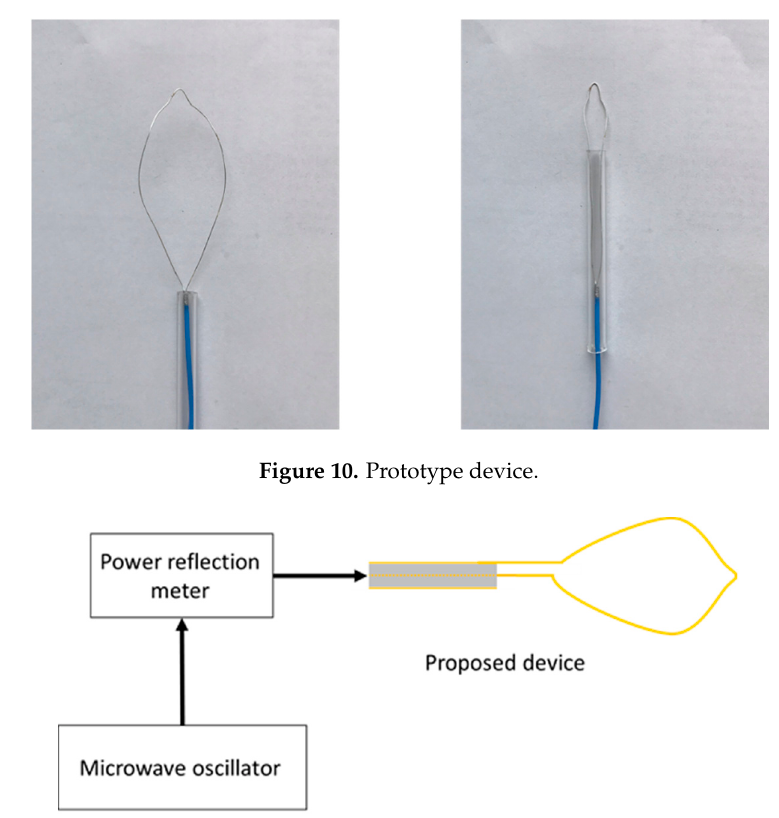
Figure 11. Experimental system.